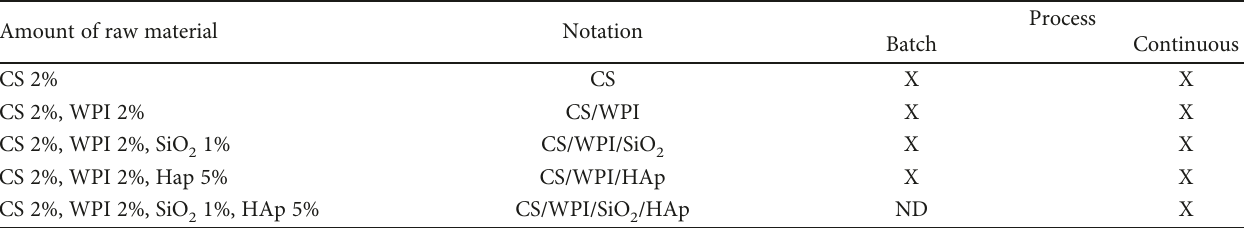
Table 1: Composition of raw material (in % w / v ) in acetic acid 1% (( v / v ) in distilled water). Amount of raw material